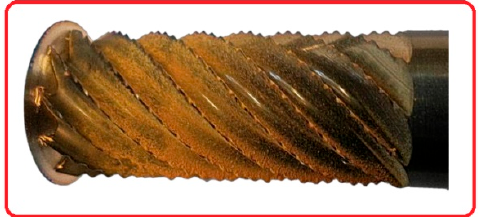
Figure 6. Accumulation of yellow powder on the CZ10 cutting tool.